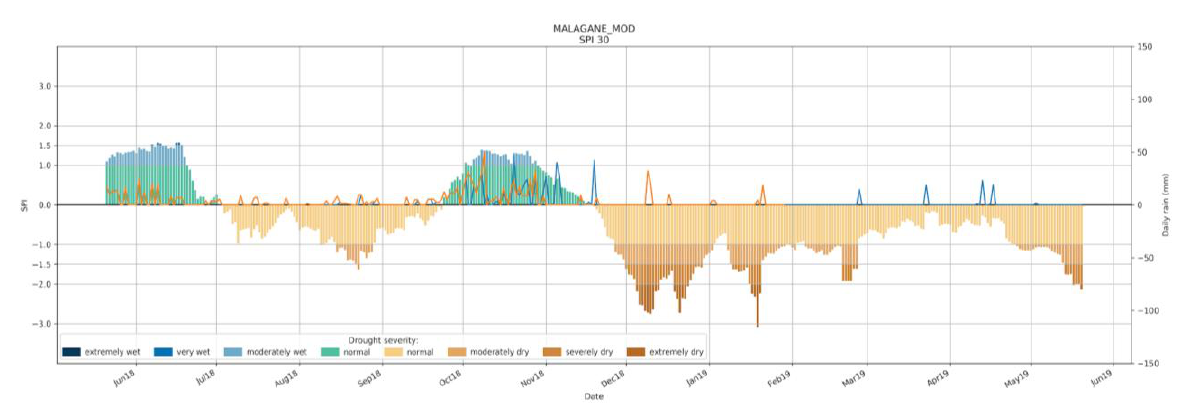
Figure 7. The SPI 30 calculated for the Malagane station for the last 365 days plus CHIRPS dataset (line orange) and Malagane station dataset (line